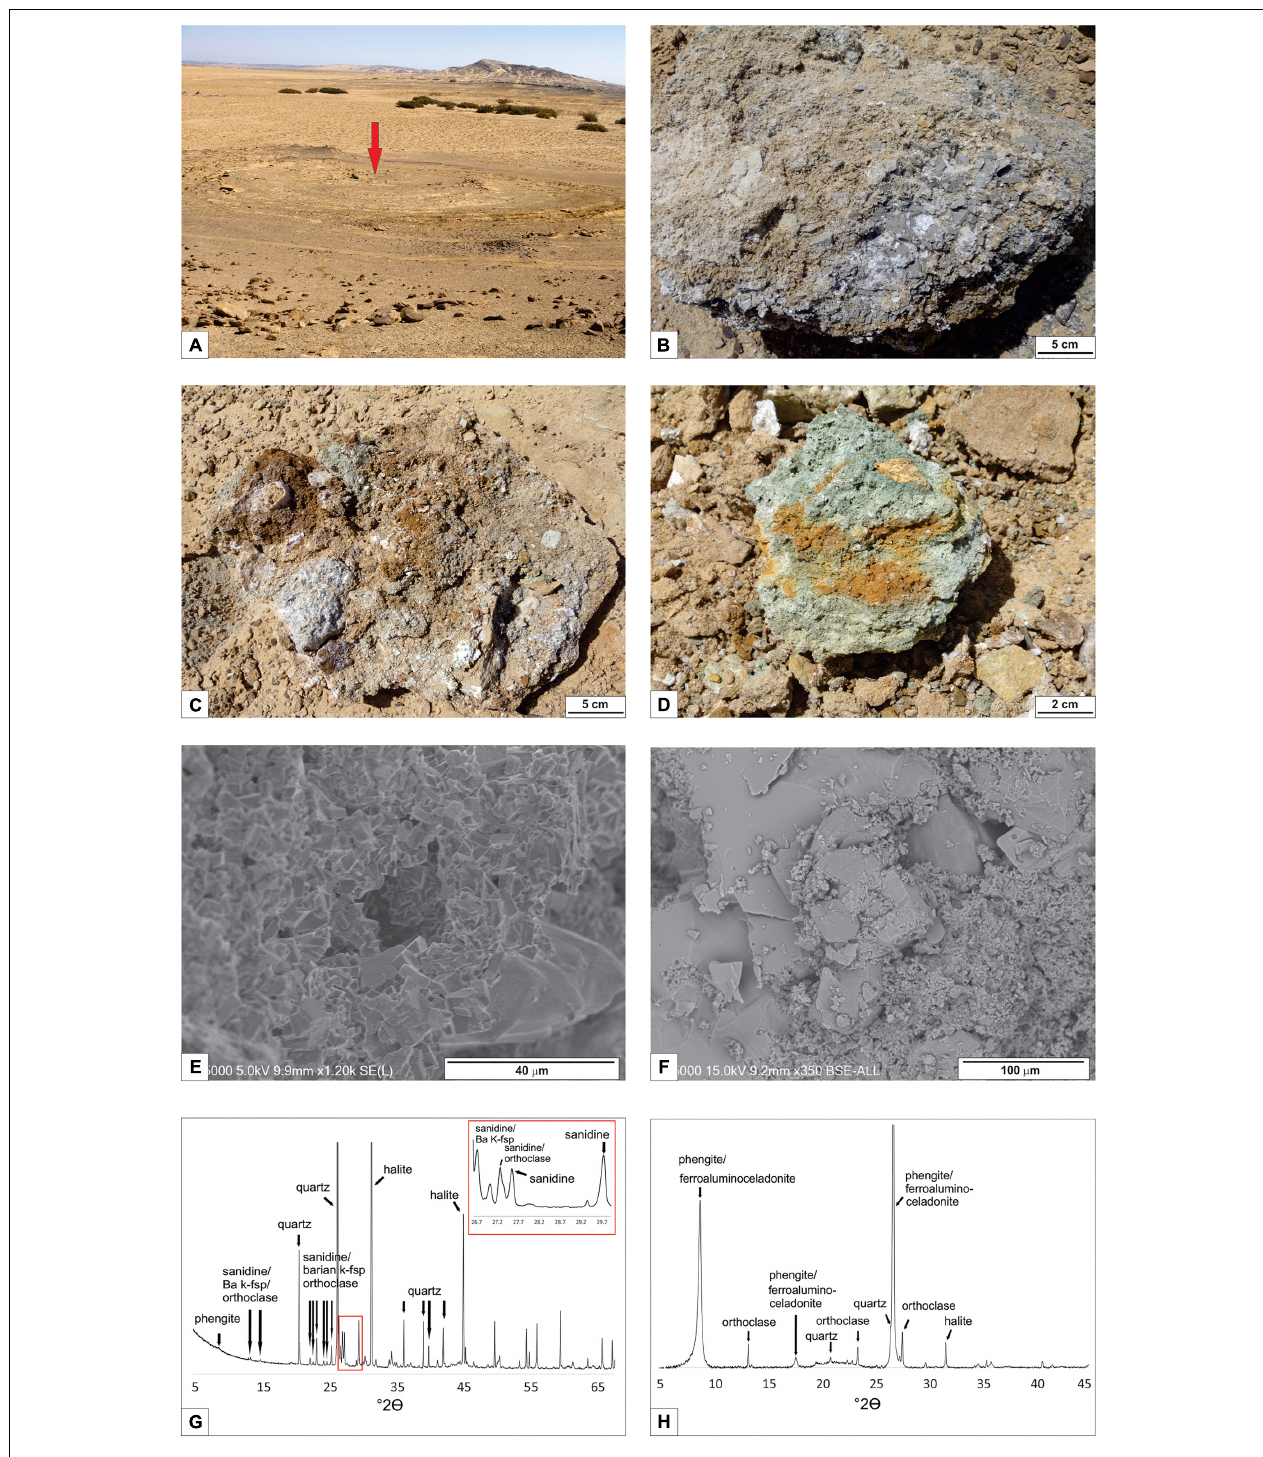
FIGURE 6 | Petrography of the central part of the CS. (A) Panoramic view of the central part of one CS; note the concentric rings of inward dipping sandstone and shale host rocks. The diameter of the outer circles ∼ 20 m. Red arrow indicates the centre of the CS. (B,C) sediments dug out from the central part of the CS show brecciated shale and sandstone clasts within a fine-grained matrix cemented by halite (white crystals). (D) Detail of one of the greenish colored conduits. (E) SEM image of K-feldspar coated microconduit through which hydrothermal fluids promoted the precipitation of high temperature minerals. (F) Subrounded quartz grains and halite are overgrown by the last fine-grained GIV ferroaluminoceladonite. (G) XRD diagram of one of the rock samples from the central conduit of CS with the major peak positions of identified minerals. (H) XRD diagram of the textured sample for the identification of clay minerals ( < 2 µ m grain size fraction). Note that the clay peak at 8.8 ◦ 2 8 of phengite and ferroaluminoceladonite (two 10 Å phases) becomes more evident than in the whole rock sample.